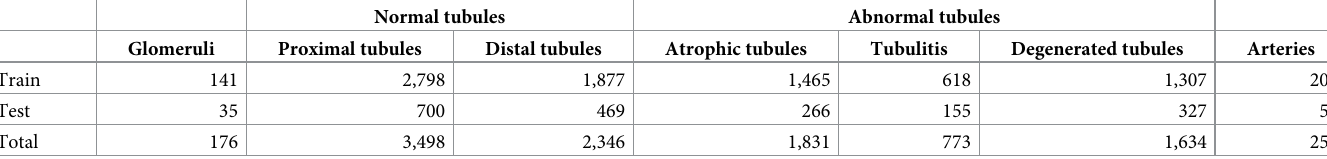
Table 2. Number of annotations per class used in the training and test sets of